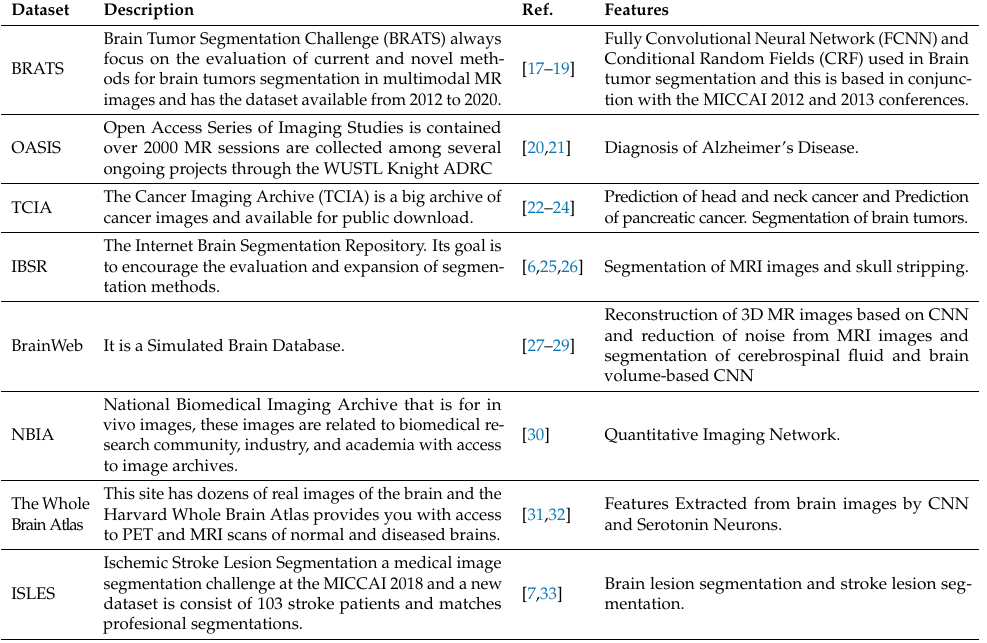
Table 2. Available datasets of MR